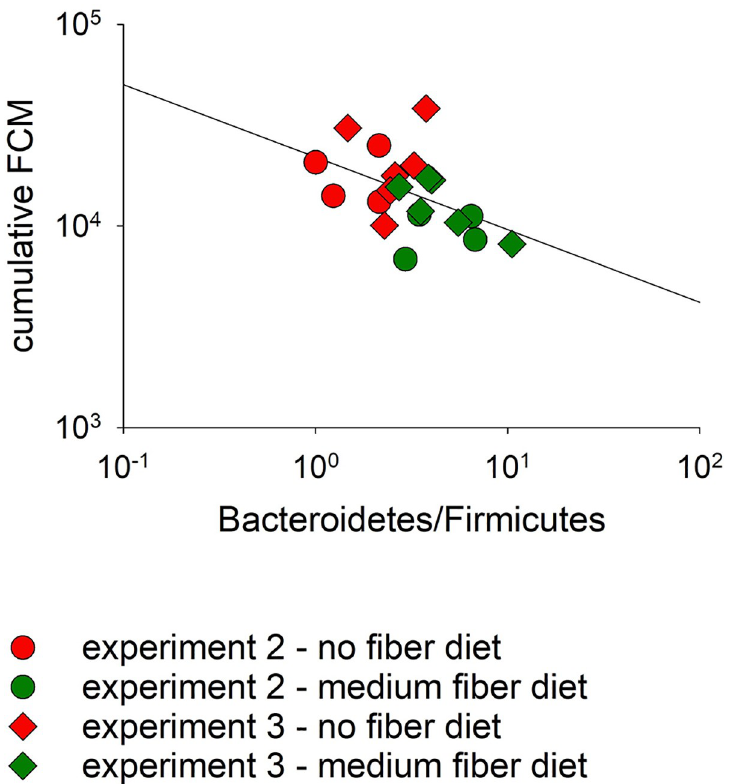
Fig 5. Bacteroidetes/Firmicutes ratio on the day of infection is negatively correlated with total oocyst output. The Bacteroidetes to Firmicutes relative abundance ratio was calculated for 20 samples from day 0 PI of experiments 2 and 3 and plotted against cumulative oocyst output on a log-log plot. 16S sequences de-noised as described in Material and Methods were classified using the method described by Wang et al. [60]. The minimum bootstrap value for taxonomic assignment was set at 70%. Color indicates diet and symbol experiment, as shown in the